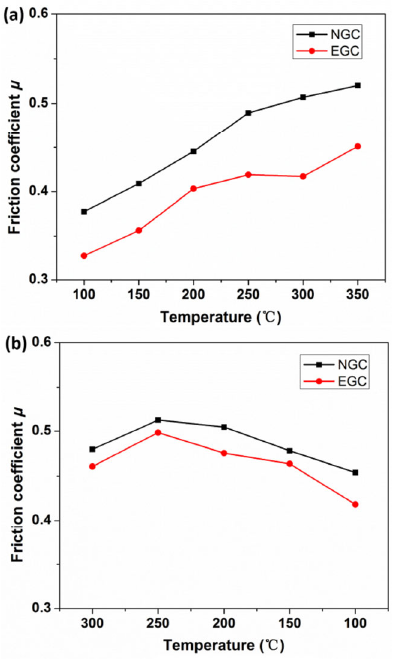
Fig. 4 Coefficients of friction for: (a) fade process and (b) recovery process.